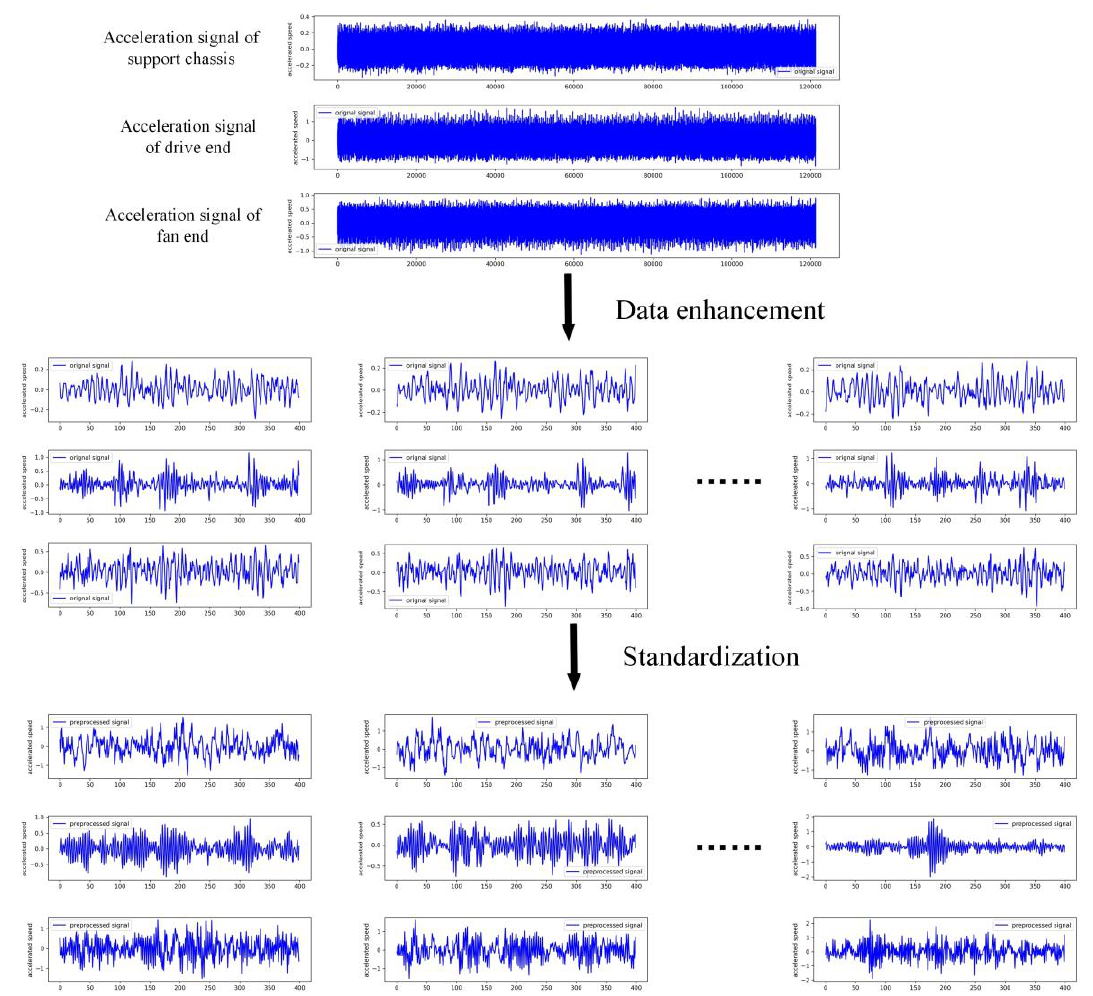
Figure 5. Graph of data preprocessing